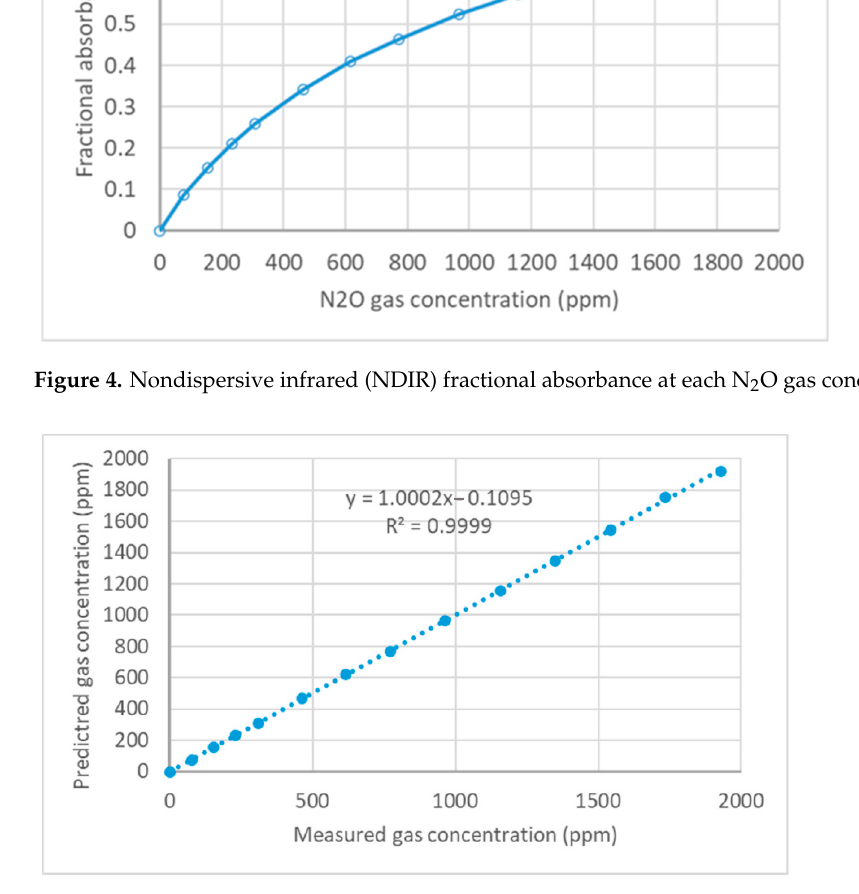
Figure 5. Regression graph of measured and predicted gas concentrations.